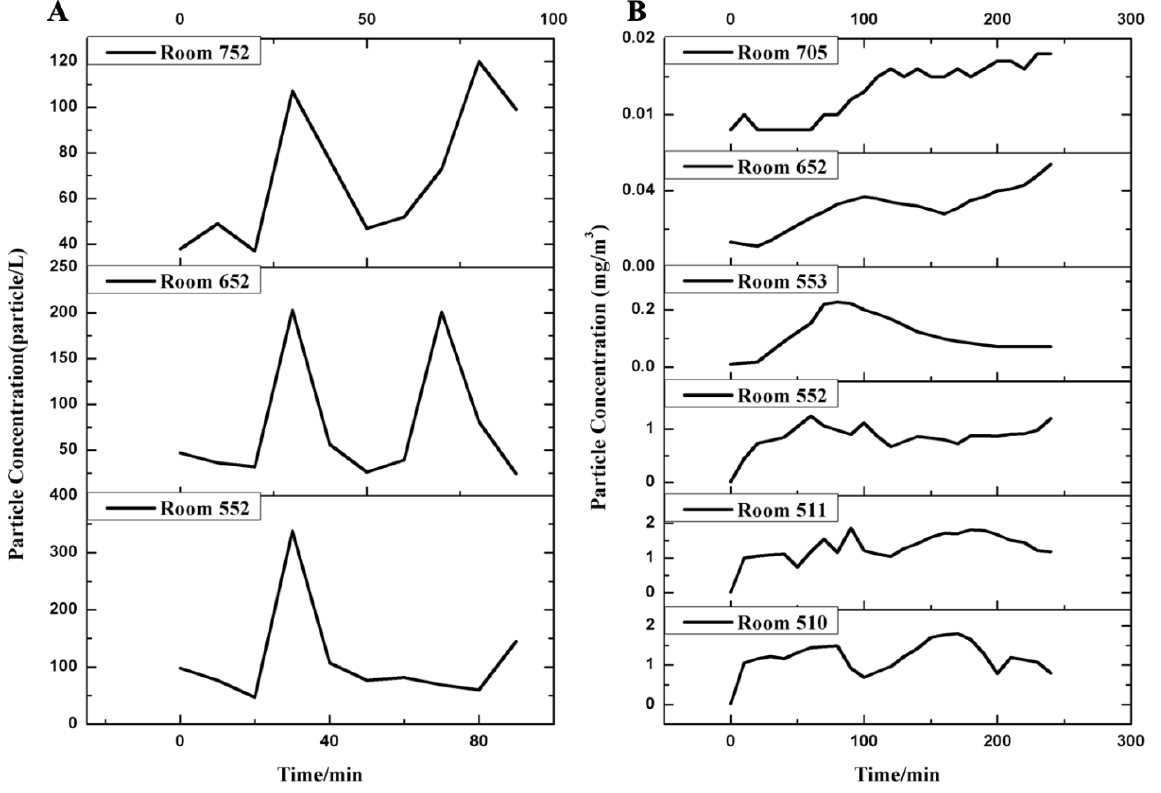
Figure 1. The changes of particle concentration over time at 0.5 μm (scenarios 1), PM 10 (scenarios 2) in different rooms. ( A ) Scenarios 1; ( B ) scenarios 2.